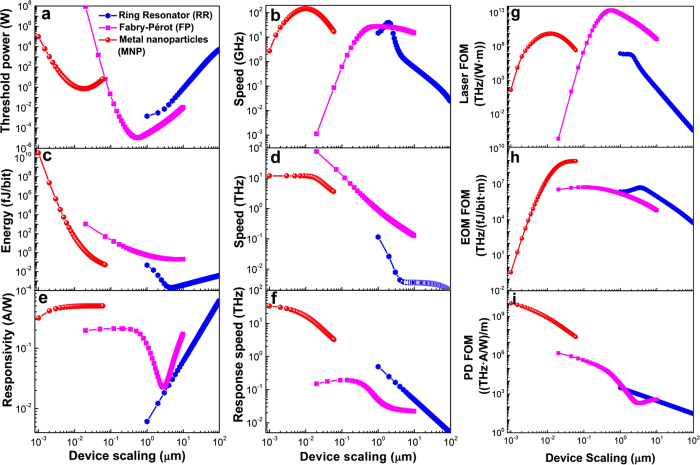
Scaling performance of electro-optic devices.(a) Laser electrical power threshold, αg = 4700 cm−1 for gain medium of InGaAsP20, τspo = 10 ns20, νsa_InP = 15000 cm/s, ηi = 0.8, ρc = 1.0 ×10−8 Ω cm2, and Rsh = 16.5 Ω/, (b) Laser modulation speed, (c) Energy efficiency of EOM, rEO = 100 pm/Vbias, (d) Modulation speed of the EOM, Rs = 500 Ω, Rdr = 500 Ω, (e) Photodetector responsivity, Δnc = 1.0 × 1014/m3, nc = 1.0 × 1019/m3, μn = 1400 cm2/Vs, νsa_Si = 10000 cm/s, Cn = 1.1 × 10−30 cm6/s, ηi = 0.8, Vbias = 2.0 V, evaluated at BW = 10 GHz, and (f) Response speed of photodetector. (g–i) Device FOMs for laser, modulator, and photodetector devices.